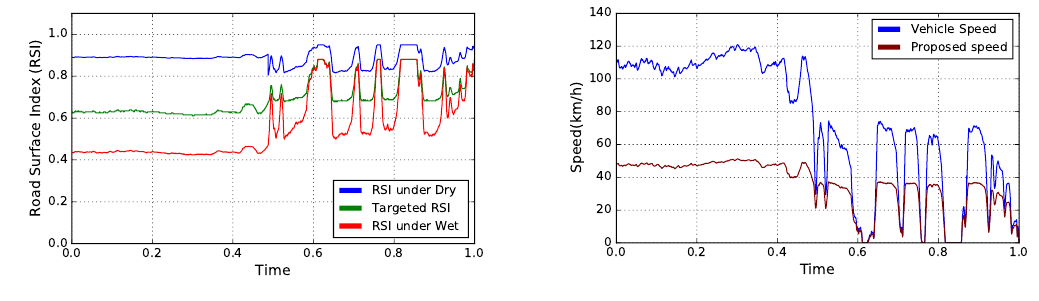
Figure 7. Highway driving